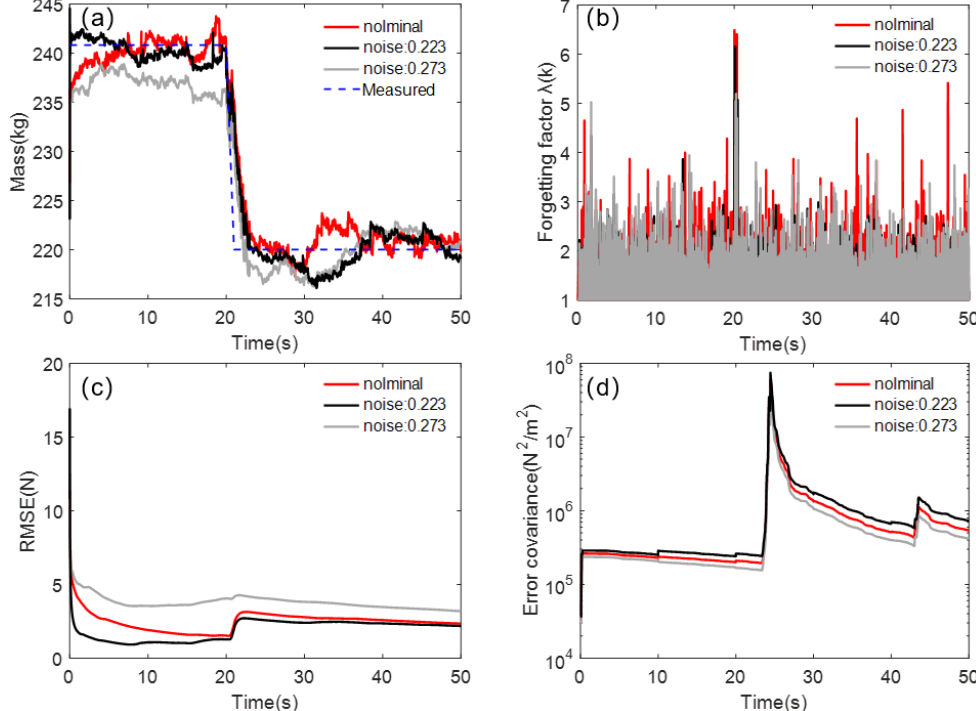
Figure 16. Experimental results of vehicle mass estimation for three data sets of Gaussian random noise; ( a ) estimated vehicle mass according to different Gaussian random noises, ( b ) time evolution of the forgetting factor, ( c ) RMSE, and ( d ) convergence history of the error covariance.